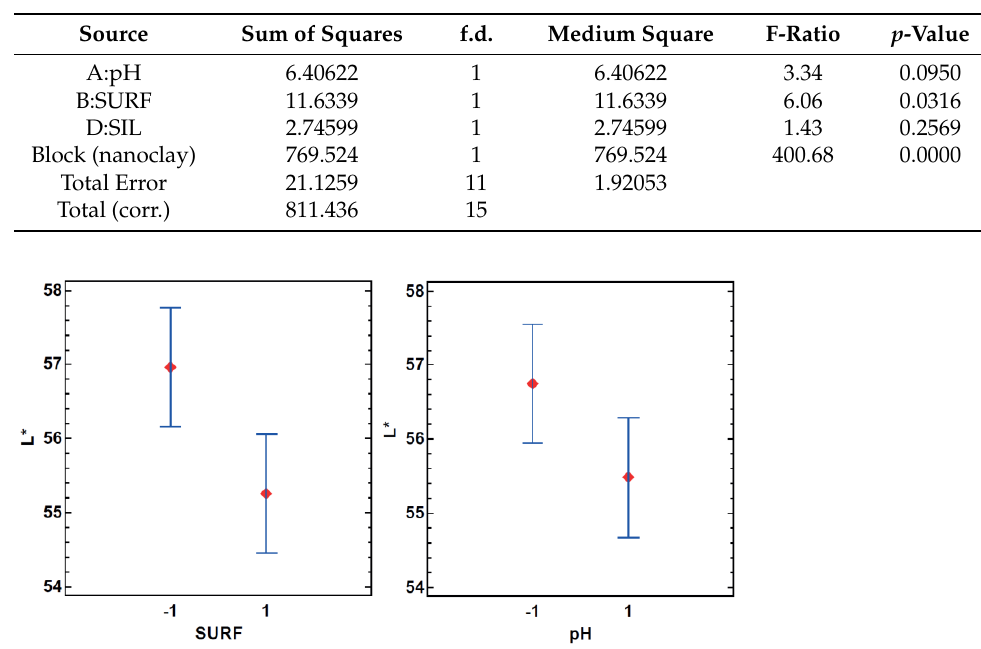
Figure 10. The LSD median plots for the SURF and CLAY factors with the C ab * response. Table 5. Analysis of variance for L* values for the different synthesis conditions by DoE 2 4 − 1 .